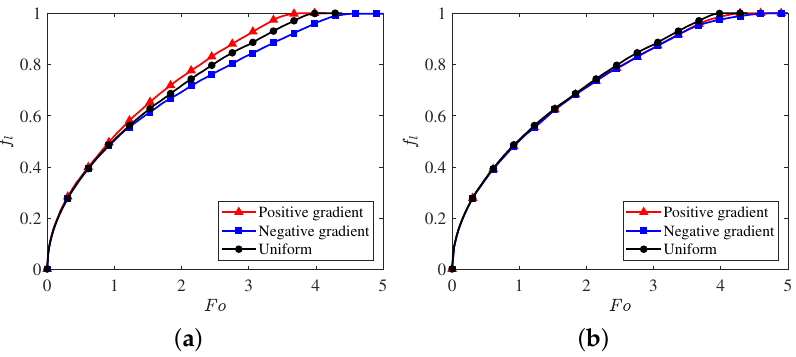
Figure 5. Comparisons of f l in three gradient structures for ( a ) case A and ( b ) case B at Ra = 10 4 , in which Ste = 0.1, and Pr =